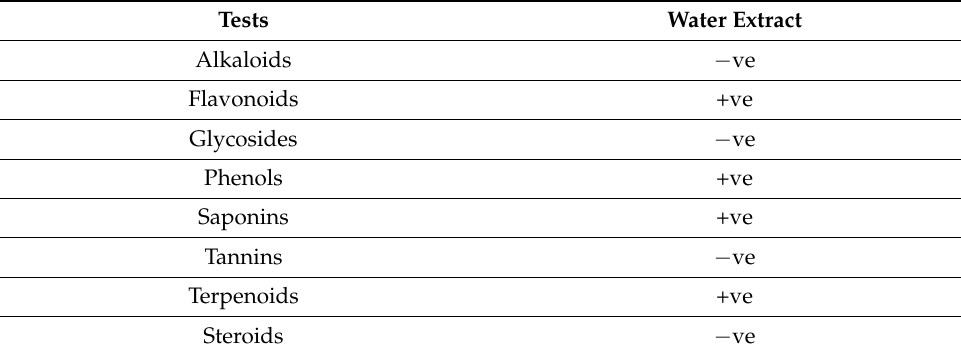
Table 1. Phytochemical analysis of aqueous leaf extract of V. leucoxylon . Tests Water Extract Alkaloids − ve Flavonoids +ve Glycosides − ve Phenols +ve Saponins +ve Tannins − ve Terpenoids +ve